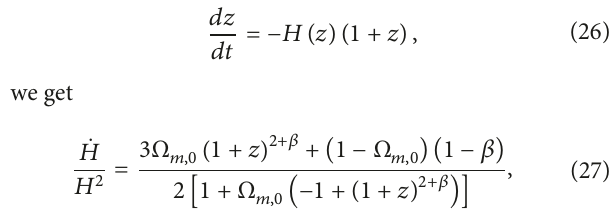
In both cases, (20) and (27), A is of the same order of 1 − Ω 𝑚,0 , but in the second case it is much closer to